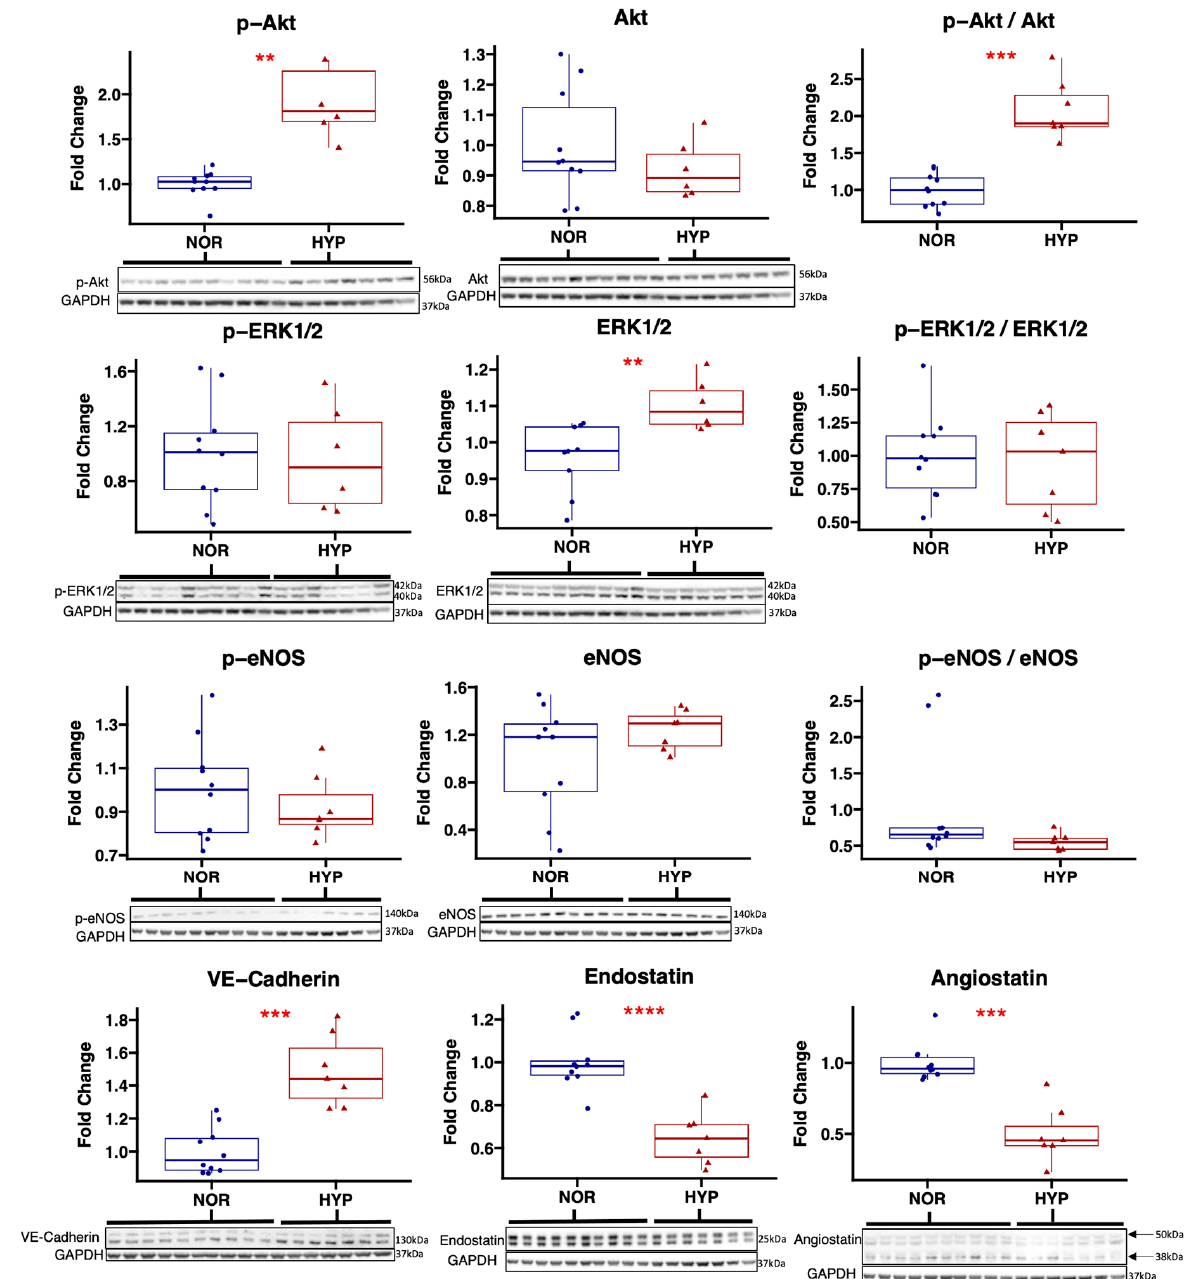
Figure 4. Hypoxia-modified EV treatment increased pro-angiogenic signaling and decreased anti-angiogenic signaling in chronically ischemic myocardium compared to normoxia EV treatment. Immunoblot results from total protein lysates of chronically ischemic myocardium in swine treated with hypoxia-modified EVs (HYP, n = 7) compared to normoxia serum-starved EVs (NOR, n = 10) are shown for pro-angiogenic markers Akt, phosphorylated (p-) Akt, and the ratio of p-Akt to Akt; extracellular signal-regulated kinase 1/2 (ERK1/2), p-ERK1/2, and the ratio of p-ERK 1/2 to ERK1/2; endothelial nitric oxide synthase (eNOS), p-eNOS, and the ratio of p-eNOS and eNOS; and vascular endothelial cadherin (VE-Cadherin). Immunoblot results are also shown for anti-angiogenic markers angiostatin and endostatin. Upper and lower borders of box represent upper and lower quartiles; middle horizontal line represents median; upper and lower whiskers represent maximum and minimum values. ** p < 0.01, *** p < 0.001, **** p < 0.0001.